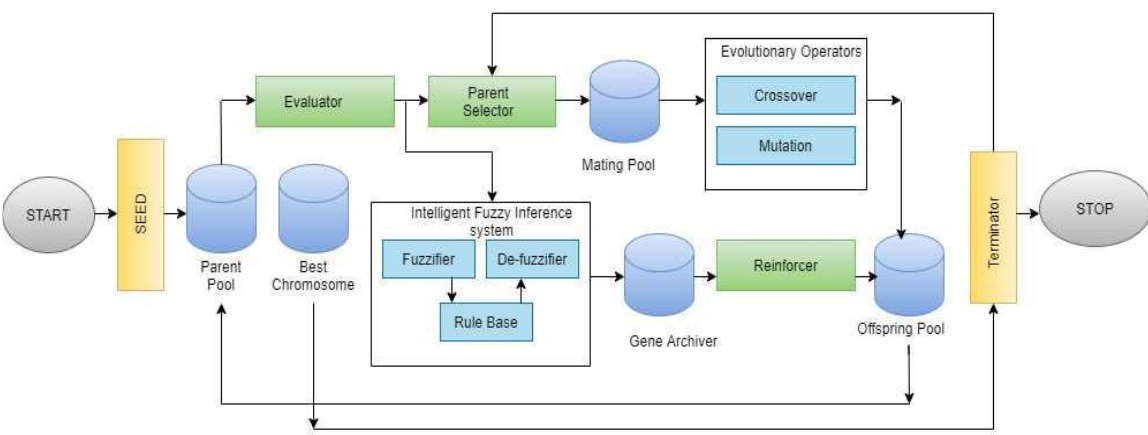
Figure 4. Detailed design of the GA – fuzzy inference model.